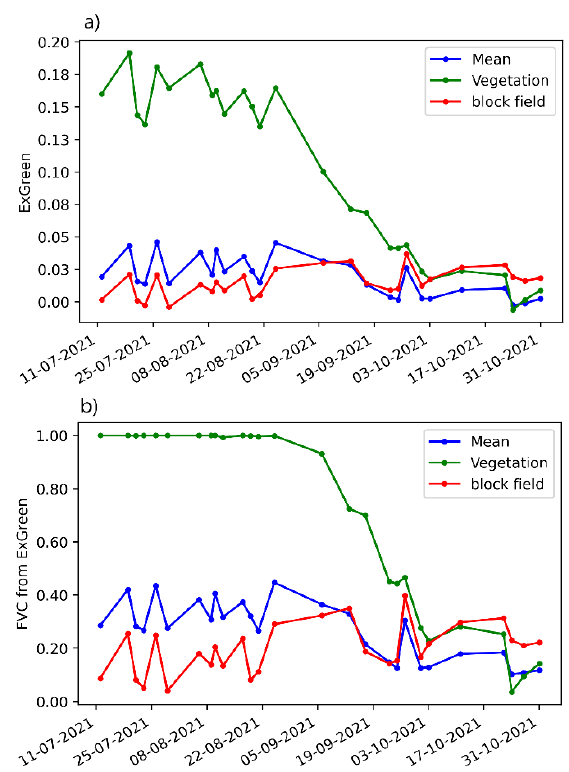
Figure 9. Time series of ExG (a) and FVC (b) for two different surface